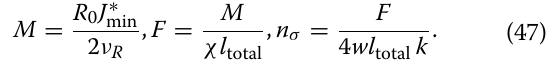
Figure 9 Variations of the bite angle, neutral angle, and location of neutral points in upward rolling